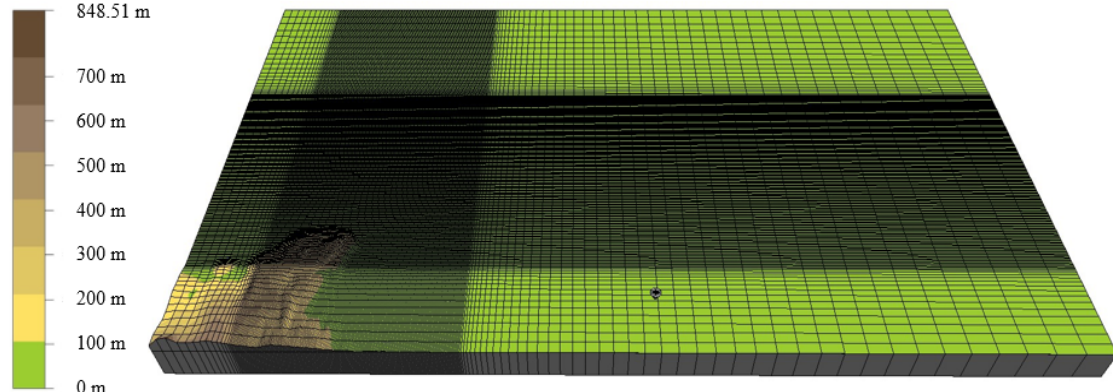
Figure 10. Terrain model grid of Wetar Island with the wind data source location. Table 4. Mesh of terrain.